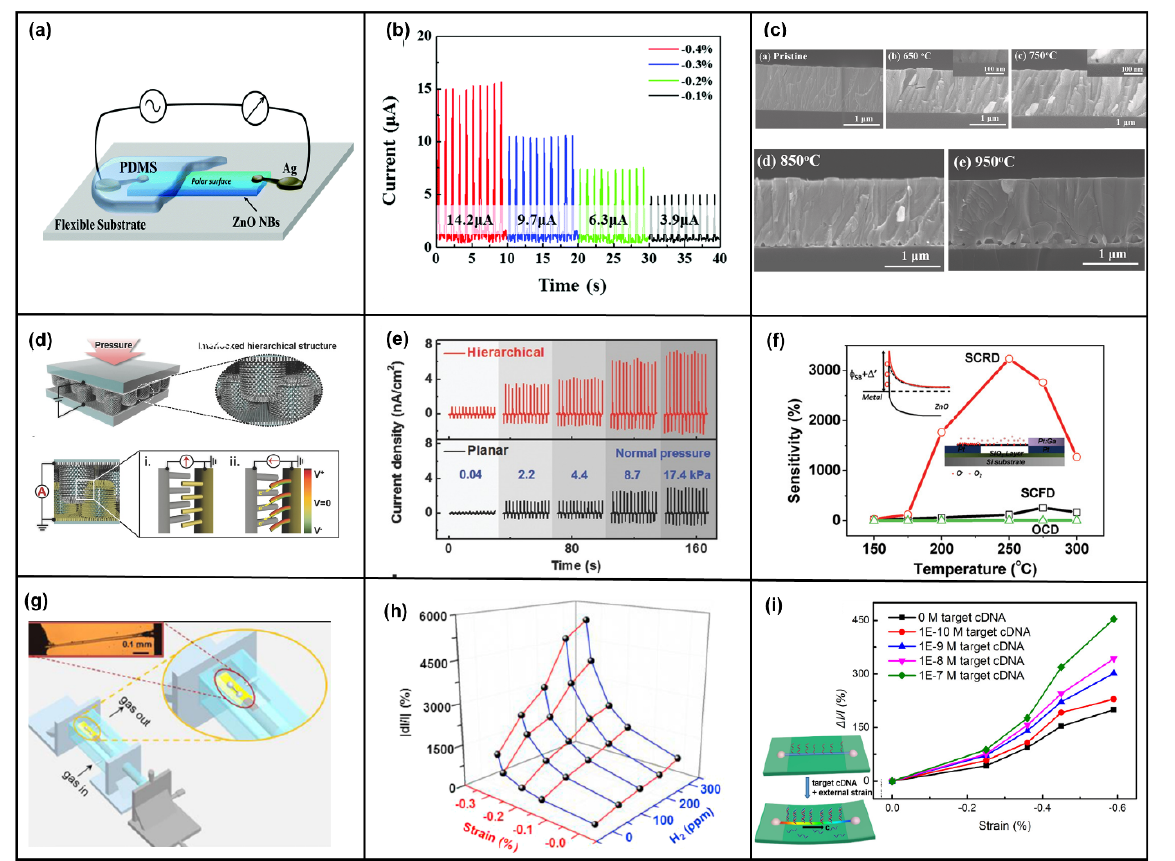
Figure 2. Device structure and the characterization of the In–ZnO nanoribbon (NB). ( a ) Device structure of the strain sensor of the In–ZnO NB. ( b ) The current response under different compressive strains. Reproduced with permission from [92]. Copyright (2015) Nanoscale . ( c ) Cross-sectional SEM images of as-grown and post-annealed ZnO thin film on Si at 650 °C, 750 °C, 850 °C, and 950 °C. Reproduced with permission from [94]. Copyright (2021) Nano Energy . Schematic diagram and electrical characteristics of device structure of bionic interlocking ZnO NW array. ( d ) Device structure and ( e ) current output density of nanogenerators. Reproduced with permission from [102]. Copyright (2015) Advanced Functional Materials . ( f ) The structure of Schottky’s contact ZnO NW gas sensor and sensitivity versus system temperature for O 2 sensing. Reproduced with permission from [104]. Copyright (2009) Journal of the American Chemical Society . Schematic diagram and current test diagram of a piezoelectric effect enhanced nanowire gas sensor. ( g ) Schematic diagram of experimental equipment. Inset: optical image of a gas sensor device. ( h ) The amplitude of change in current under the action of hydrogen and pressure. Reproduced with permission from [105]. Copyright (2015) Nano Energy . ( i ) Relative current response under different compressive strains of Schottky-exposed ZnO NW DNA sensors. Inset: device structure. Reproduced with permission from [107]. Copyright (2016) American Chemical Society Nano .